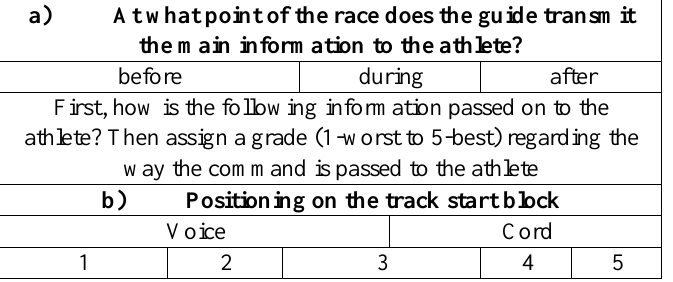
Table 2: Interview questions to